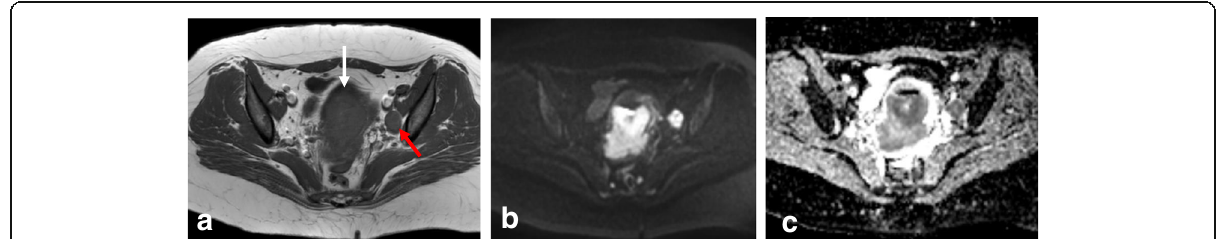
Fig. 24 Axial oblique T2W ( a ) and DWI images ( b , c ) showing stage IIIC 1 endometrial cancer (white arrow) with metastatic left obturatory lymph node (red arrow)